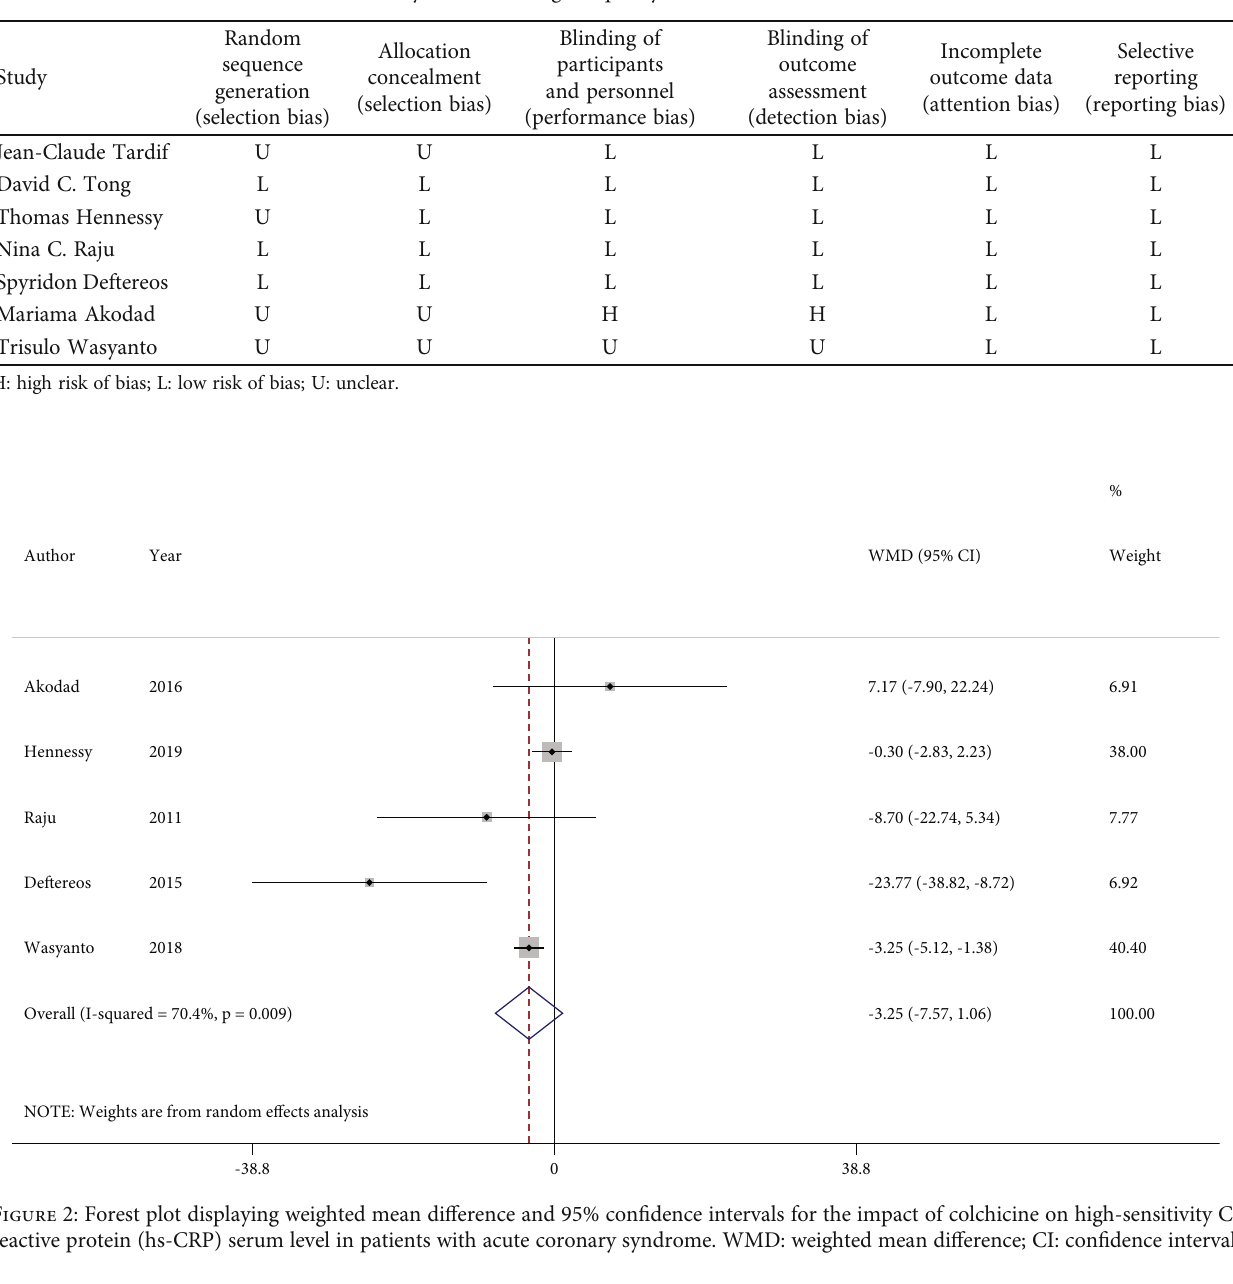
Table 3: Summary of methodological quality assessment of the included studies.